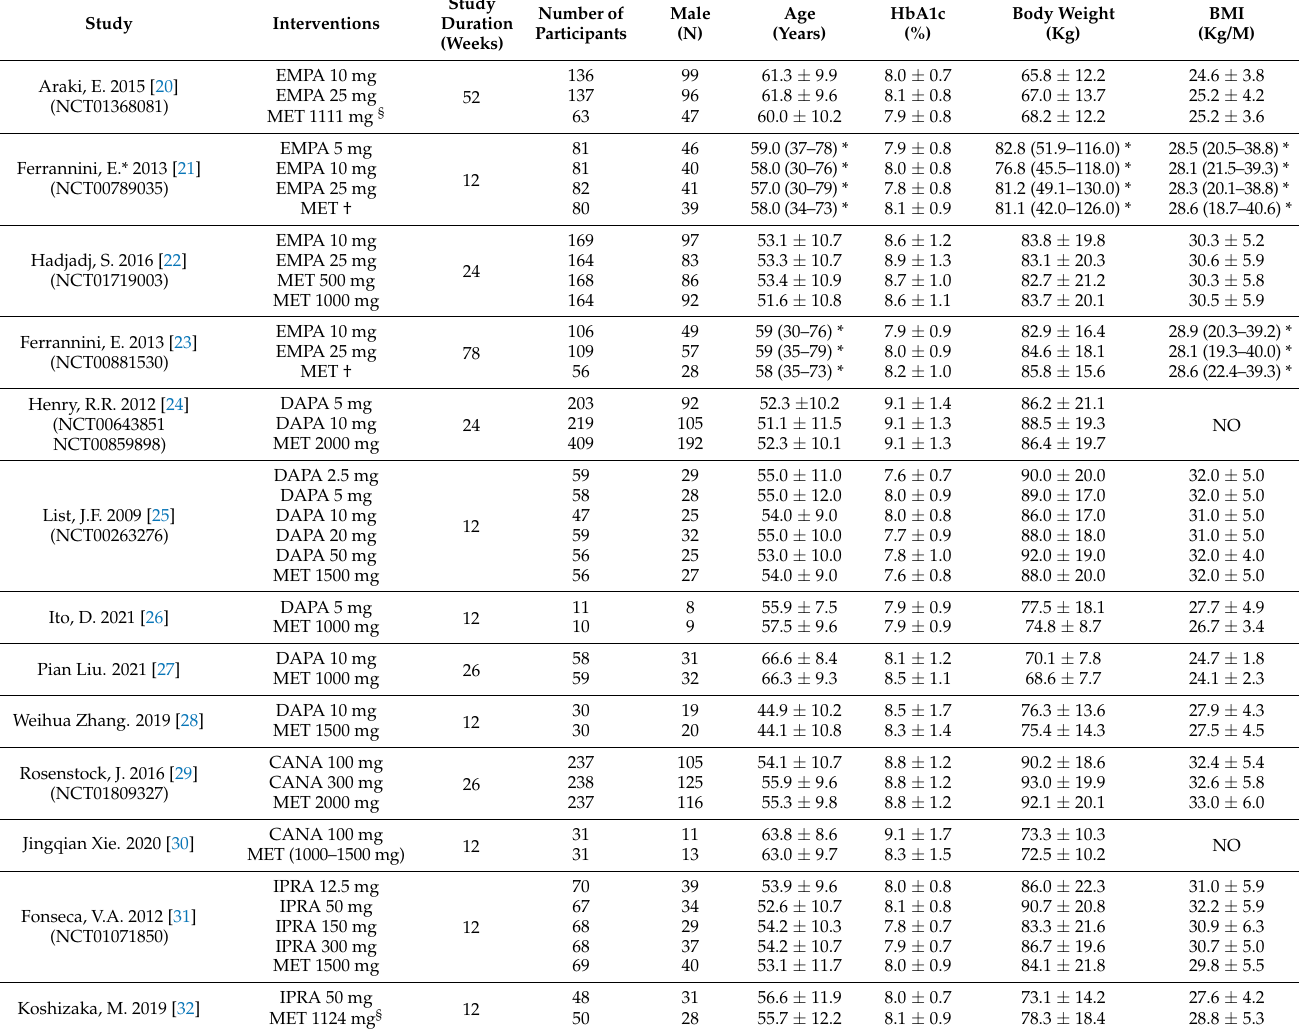
Table 1. Basic characteristics of randomized controlled trials included in the